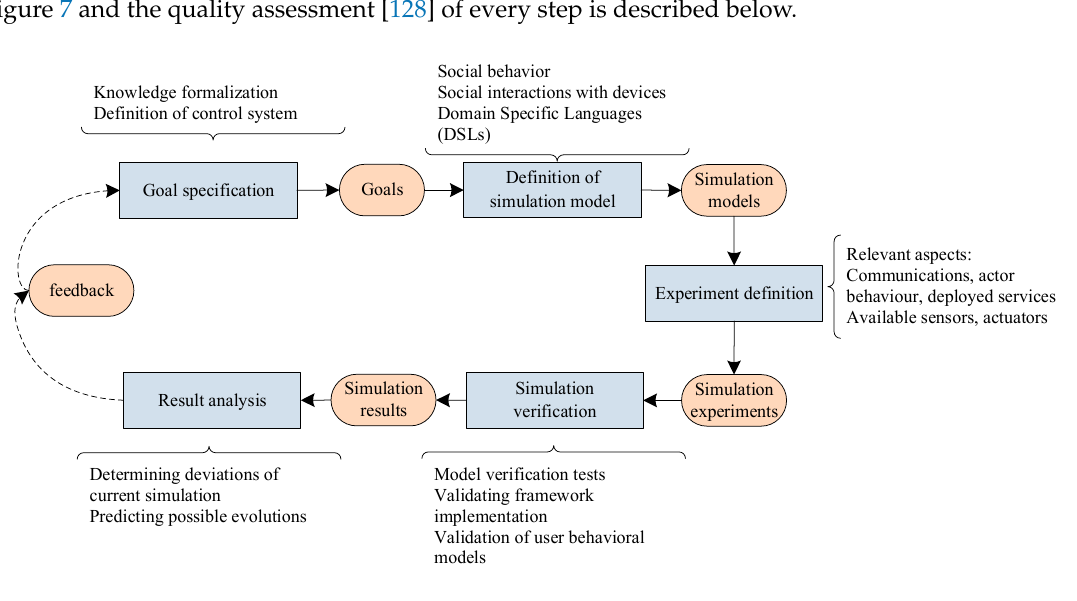
Figure 7. Basic simulation lifecycle.